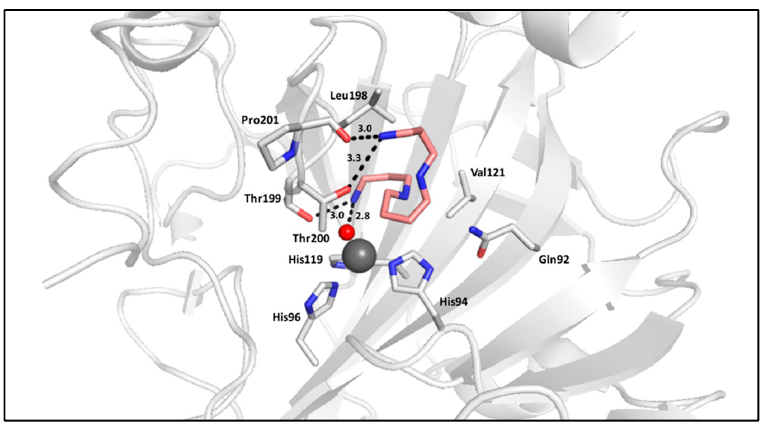
Figure 4. Spermine ( salmon ) in complex with CA ΙΙ ( gray ) (PDB:3KWA) [41].